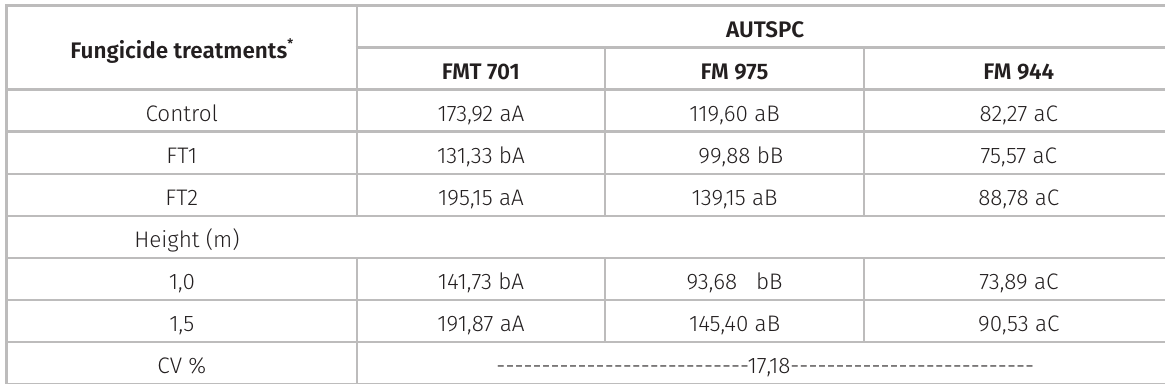
Averages followed by the same letter, lowercase letter in the columns and capital letter in the lines, do not differ among themselves by Scott-Knott’s test at 5% of probability. *Control; FT1- Active ingredients and sprays starting at B1 stage with interval of 15 days until 75 days (Piraclostrobin + Fluxapyroxad (B1), Trifloxystrobin + Prothioconazole (B1+15), Piraclostrobin + Fluxapyroxad (B1+30), Piraclostrobin + Fluxapyroxad (B1+45), Piraclostrobin + Fluxapyroxad (B1+60), Trifloxystrobin + Prothioconazole (B1+75)); FT 2- Active ingredients and sprays starting at B1 stage with interval of 15 days until 75 days (Azoxistrobin + Difenoconazole (B1), Difenoconazole (B1+15), Azoxistrobin + Difenoconazole (B1+30), Azoxistrobin + Difenoconazole (B1+45), Azoxistrobin + Difenoconazole (B1+60), Difenoconazole